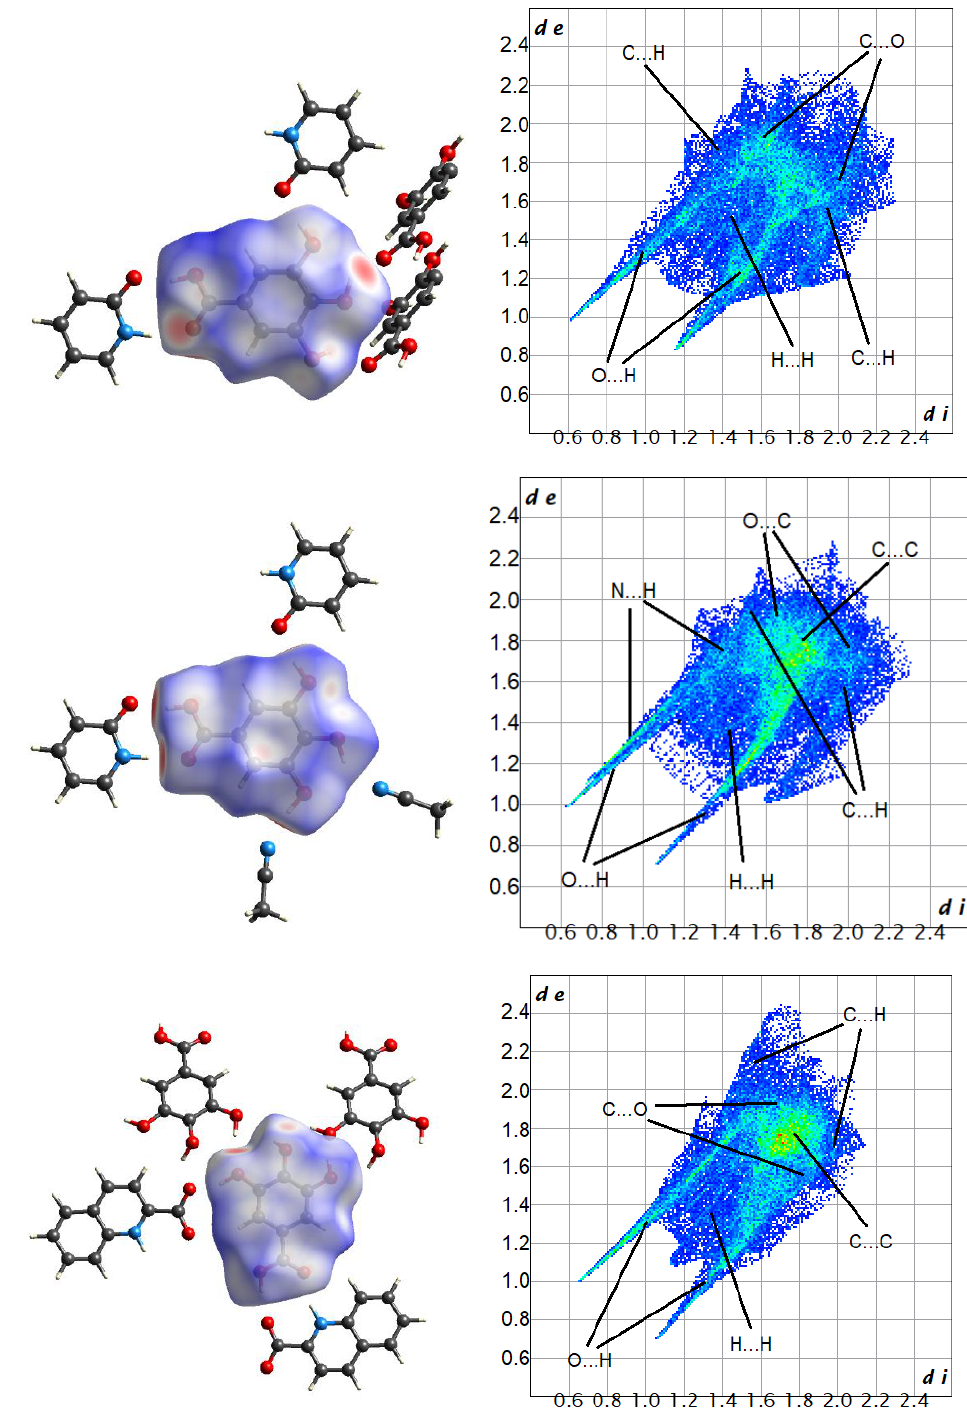
Figure 4. Hirshfeld surfaces ( left ) of the gallic acid molecule in the co-crystals 1 ( top ), 2 ( center ), and 3 ( bottom ) and their 2D fingerprint plots ( right ) as generated by Crystal Explorer [83]. Hereinafter, on the Hirshfeld surfaces ( left ), the red, white, and blue color recognizes the interatomic contacts as shorter than, equal to, or longer than the van der Waals interatomic distances, respectively. On fingerprint plots ( right ), higher and lower concentrations of points corresponding to ( d i , d e ) pairs are shown by green and blue areas, respectively; interactions with a total contribution of less than 3% are not designated.